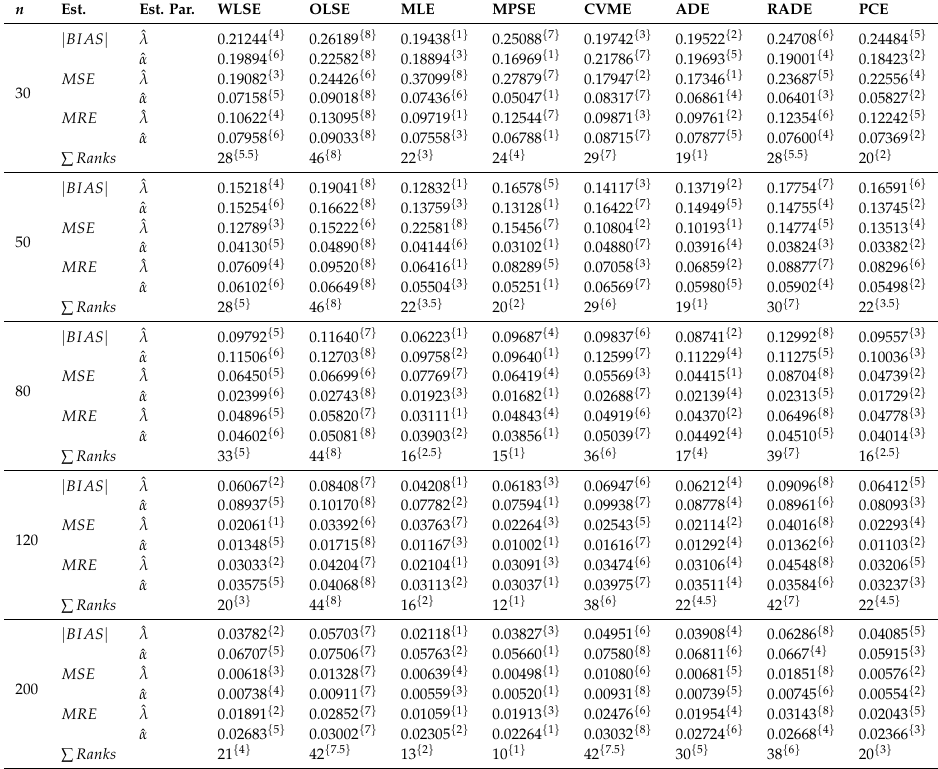
Table 3. Simulation results for φφφ = ( λ = 2.0, α = 2.5 ) (cid:124)